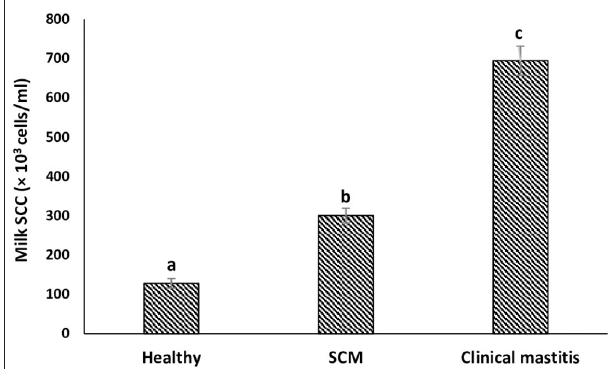
FIGURE 1 | Milk somatic cell count (SCC) in healthy, subclinical mastitis (SCM) and clinical mastitis Sahiwal cows. Data were expressed as mean ± SEM. Means statistically ( p < 0.05) different between the groups are shown with superscript letters